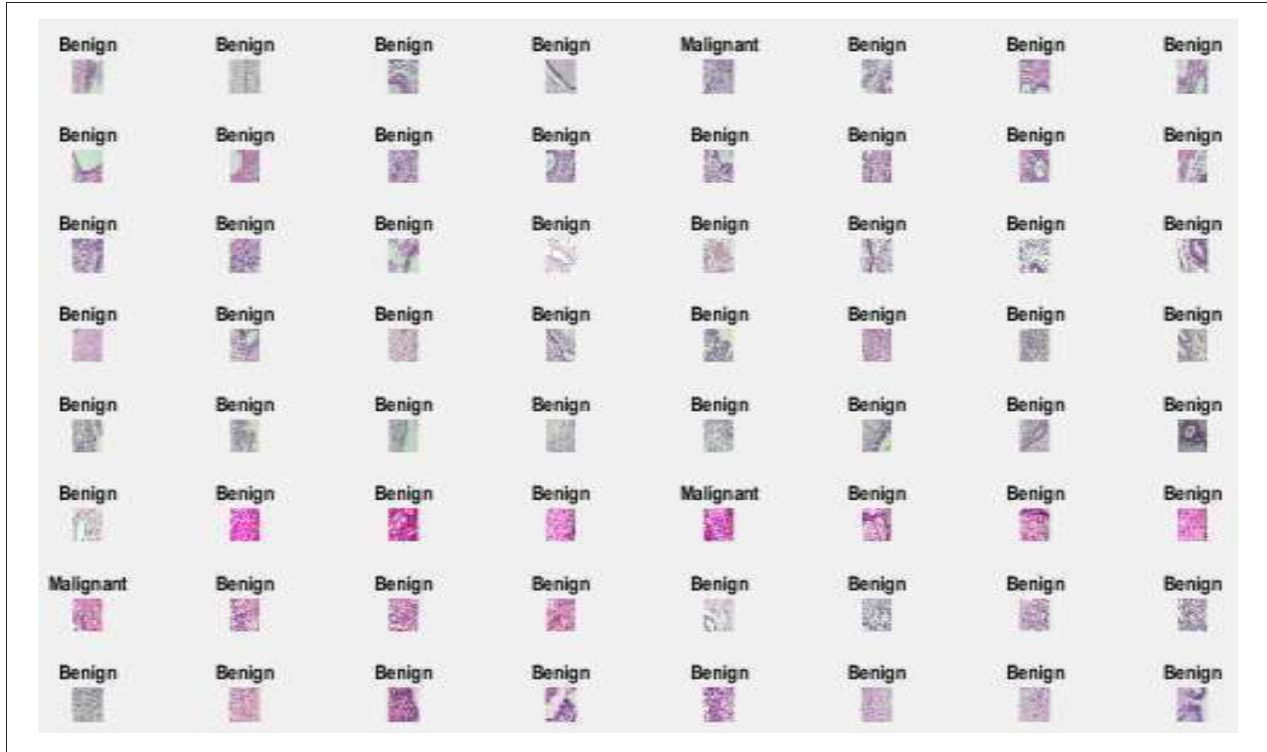
FIGURE 7 | Image classification of dataset C.